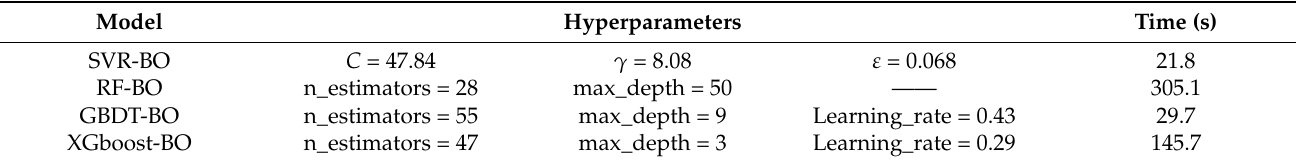
Table 3. Hyperparameters optimization results.